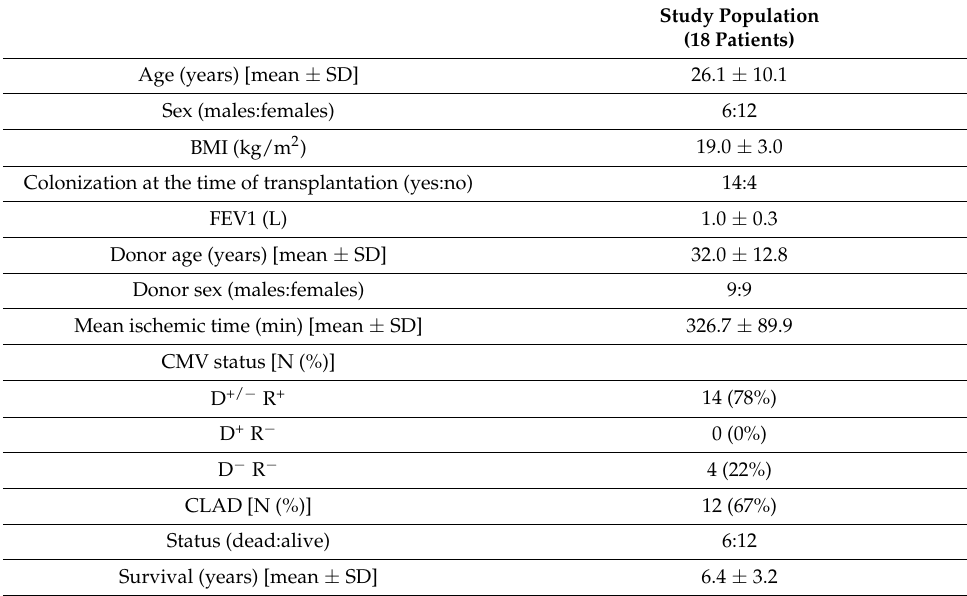
Figure 1. CONSORT diagram showing the study population and design. Table 1. Demographic data and clinical characteristics of the study population.